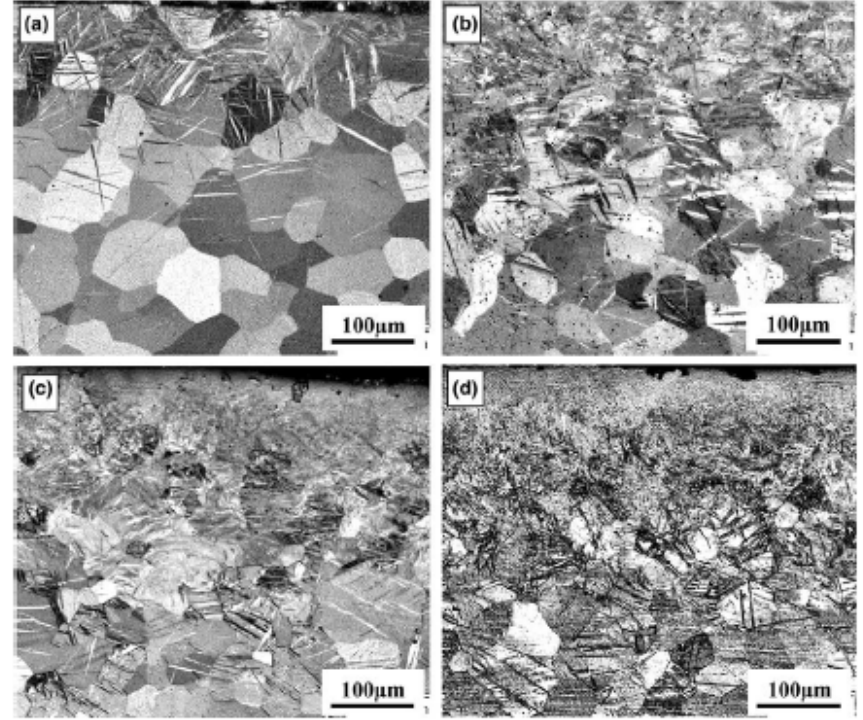
Figure 2: Typical cross-sectional optical micrographs close to the SMAT-treated surfaces under different treating conditions (annealed, commercially pure titanium